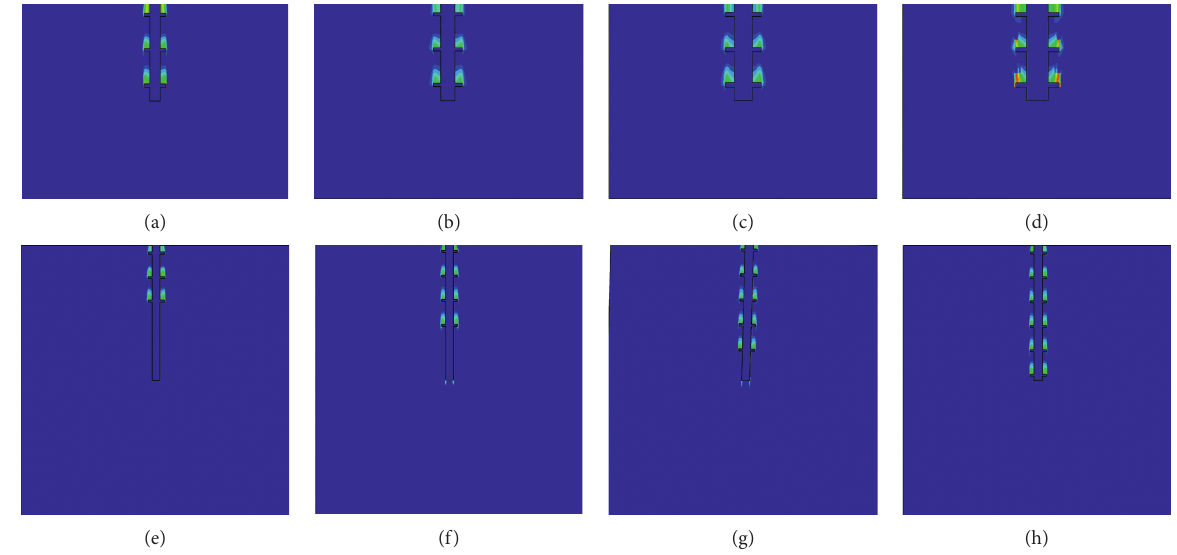
Figure 20: Plastic zone of RP with different buried depth of roots and pile diameter. (a) Diameter of 1.2m. (b) Diameter of 1.6m. (c) Diameter of 2.0m. (d) Diameter of 2.4m. (e) RP of three layers. (f) RP of four layers. (g) RP of five layers. (h) RP of six